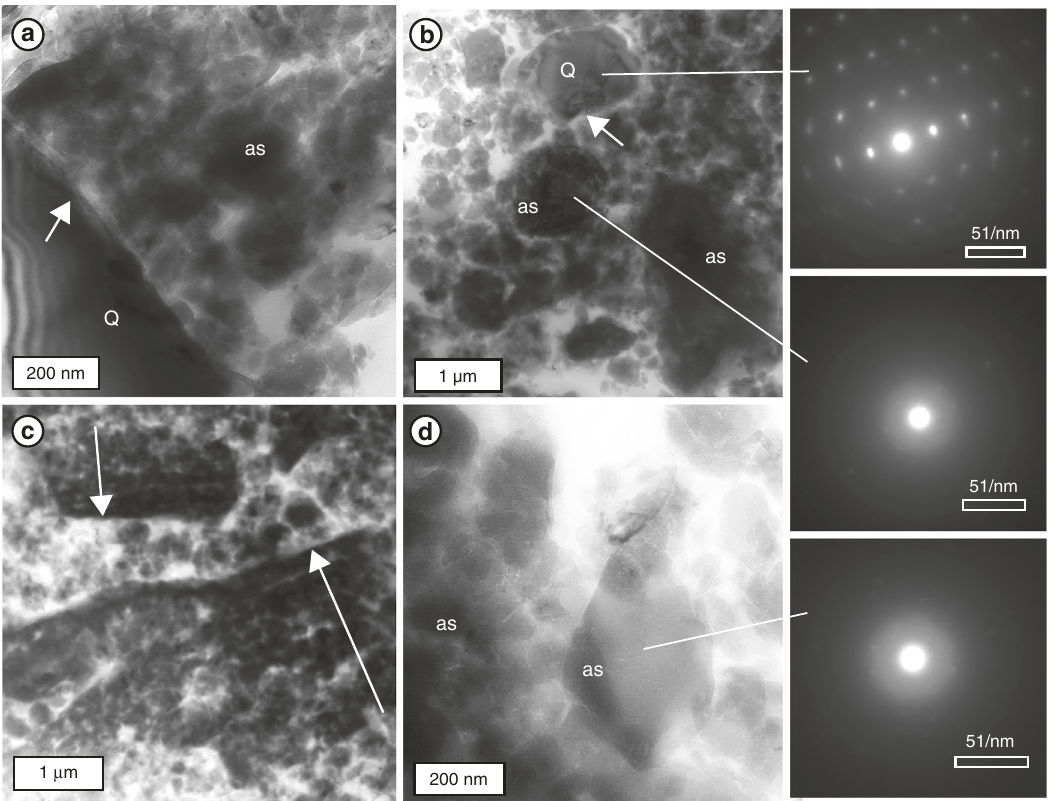
Fig. 4 Transmission Electron Microscope images of wear material from experiment 101 (bright fi eld). a Quartz grain (Q) with rough fractured surface (white arrow). Clumps of amorphous silica particles (as) surround quartz grain. b Chips of crystalline quartz (top selected area electron diffraction pattern) and rounded clumps of amorphous particles (middle selected area electron diffraction pattern). At the scale of this image, nearly all amorphous silica grains are composites of smaller particles and fragments. c Broken fragments of striated plates composed of amorphous nanoparticles. Sharp slip surface composed of gradationally increasing packing density of particles toward slip surface (white arrows). Fragments are fl oating in loosely packed amorphous nanopowder. d Wear powder of rounded to elongate particles with grain size 10 − 100 nm that show no crystal structure (bottom selected area